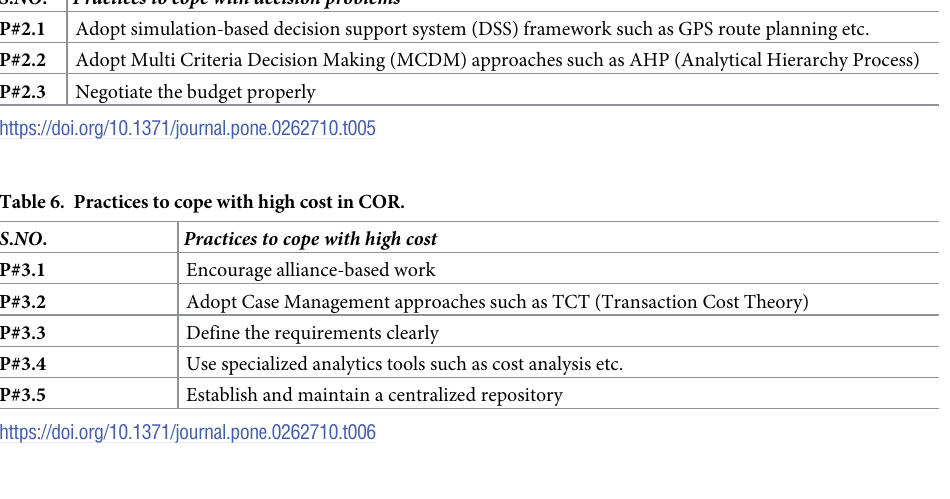
Table 7. Practices to cope with security and compliance challenges in